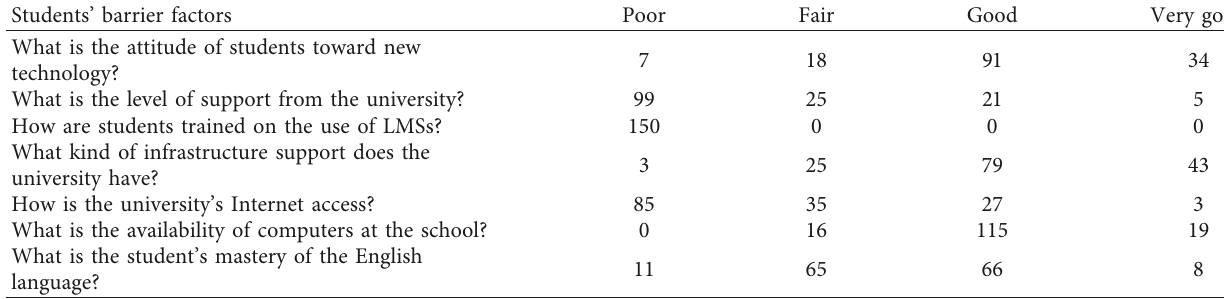
Table 2: Analysis of barriers to the student’s use of LMSs.